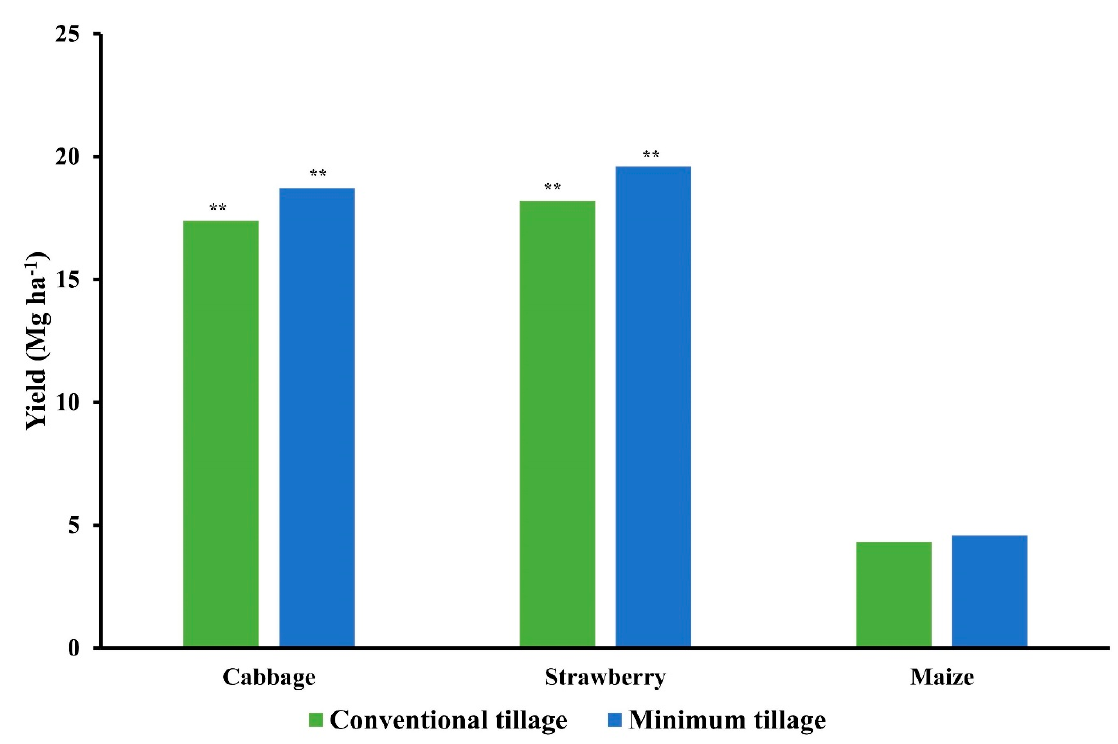
Figure 7. Comparison of yield between conventional tillage and minimum tillage of cabbage, strawberry, and maize areas. *, **, *** Significant difference at 10%, 5%, and 1% level, respectively